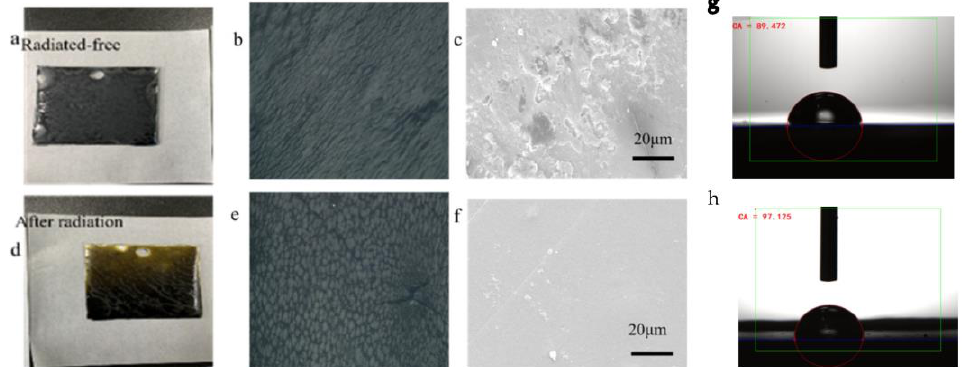
Figure 6. Digital camera, 200 × polarizing microscope, and scanning electron microscope pictures of layers under different light conditions in: ( a – c ) the coating dried in the dark; ( d – f ) the coating dried under visible light; ( g ) the water contact angle of the epoxy coating dried in the dark; and ( h ) the water contact angle of the epoxy coating dried under visible light.